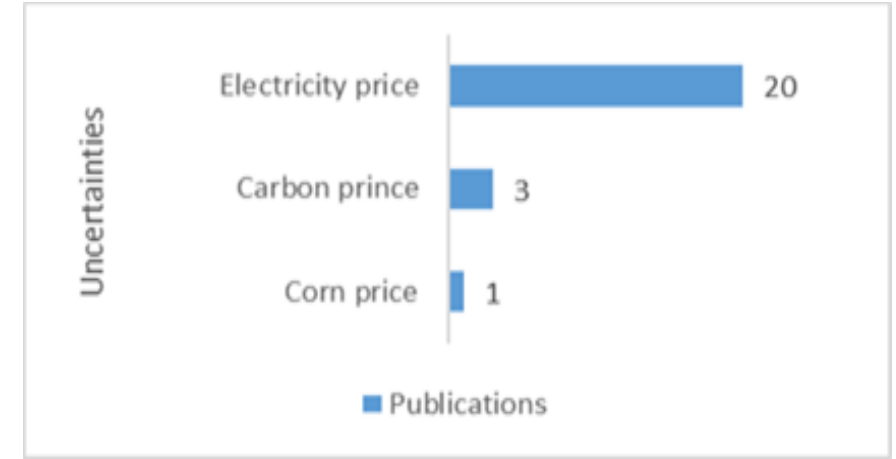
Figure 6. Energy price.